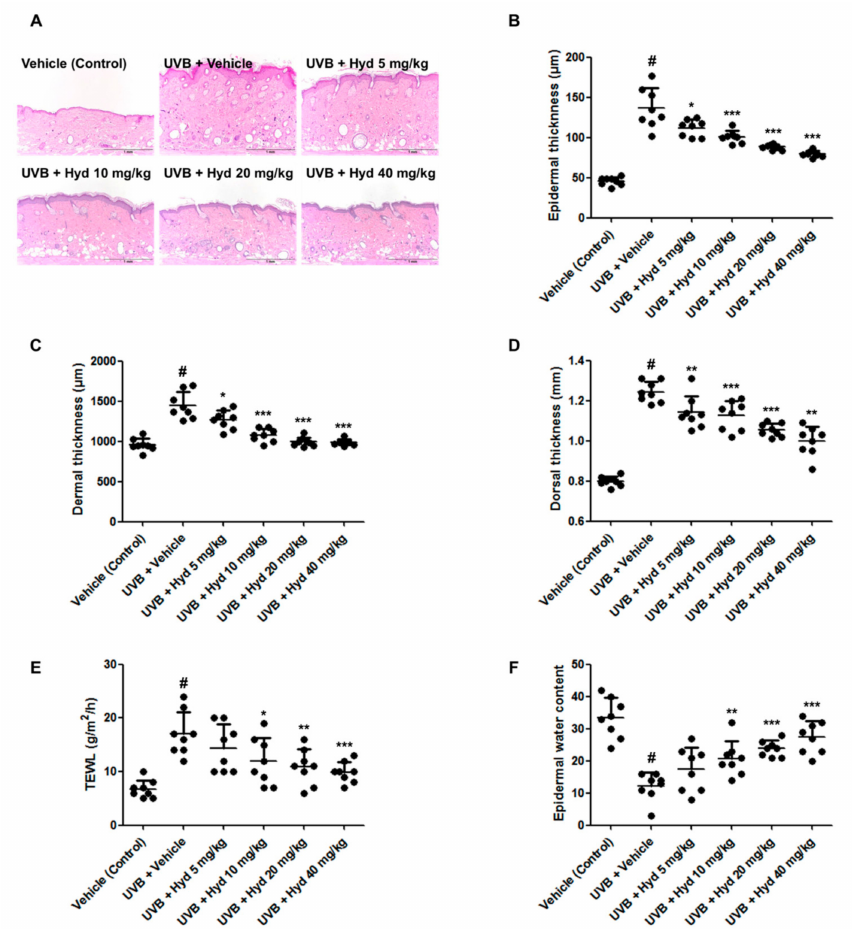
E ff ects of oral administration of hydrangenol on skin thickness, skin hydration, and transepidermal water loss (TEWL) in UVB-irradiated hairless mice. HR-1 hairless mice were administered hydrangenol (5, 10, 20, or 40 mg / kg) daily and exposed to UVB irradiation three times a week for 7 weeks. Skin tissues were stained with ( A ) hematoxylin and eosin (H&E) to aid observation of ( B ) epidermal thickness and ( C ) dermal thickness of each group of mice. ( D ) The dorsal thickness of hairless mice was measured using a caliper before sacrifice. ( E ) TEWL and ( F ) epidermal water content were measured on the dorsal surface area of the mice. Values are expressed as means ± SD ( n = 8). # p < 0.05 vs. the vehicle-treated control group; * p < 0.05, ** p < 0.01, and *** p < 0.001 as compared to the UVB + vehicle-treated